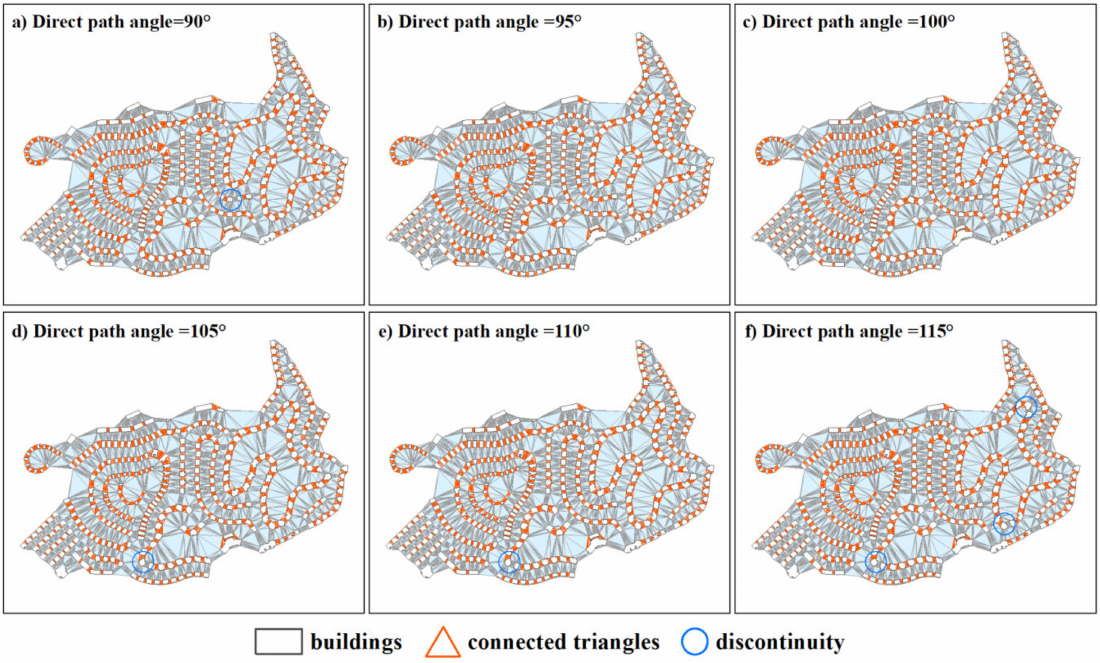
Figure 11. Results of the proposed method with di ff erent direct path angle values and indirect path angles of 65 ◦ in the SZ dataset. Buildings connected with orange edge triangles are recognized as linear building patterns.